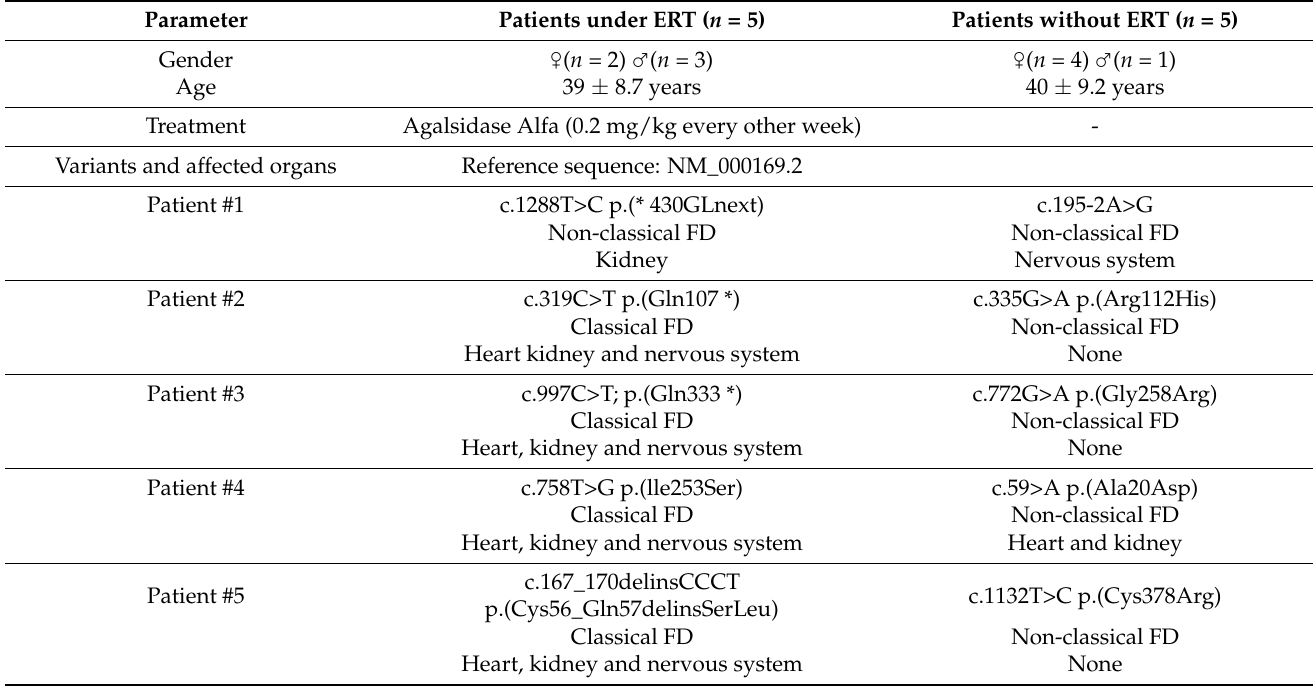
Figure 1. miRNA screening of Fabry patients. Screening of miRNA in Fabry Patients before and after enzyme replacement therapy. The difference in miRNAs in depicted in a vulcano plot ( A ) and the top 10 changed miRNAs are given in ( B ). The two top hits were analyzed in an age and sex matched cohort between untreated patients and patients under ERT therapy. Both values for let-7a and let-7d are given as fold control to the untreated matched control group ( C ). Table 2. Baseline Fabry patient (second group) characteristics.